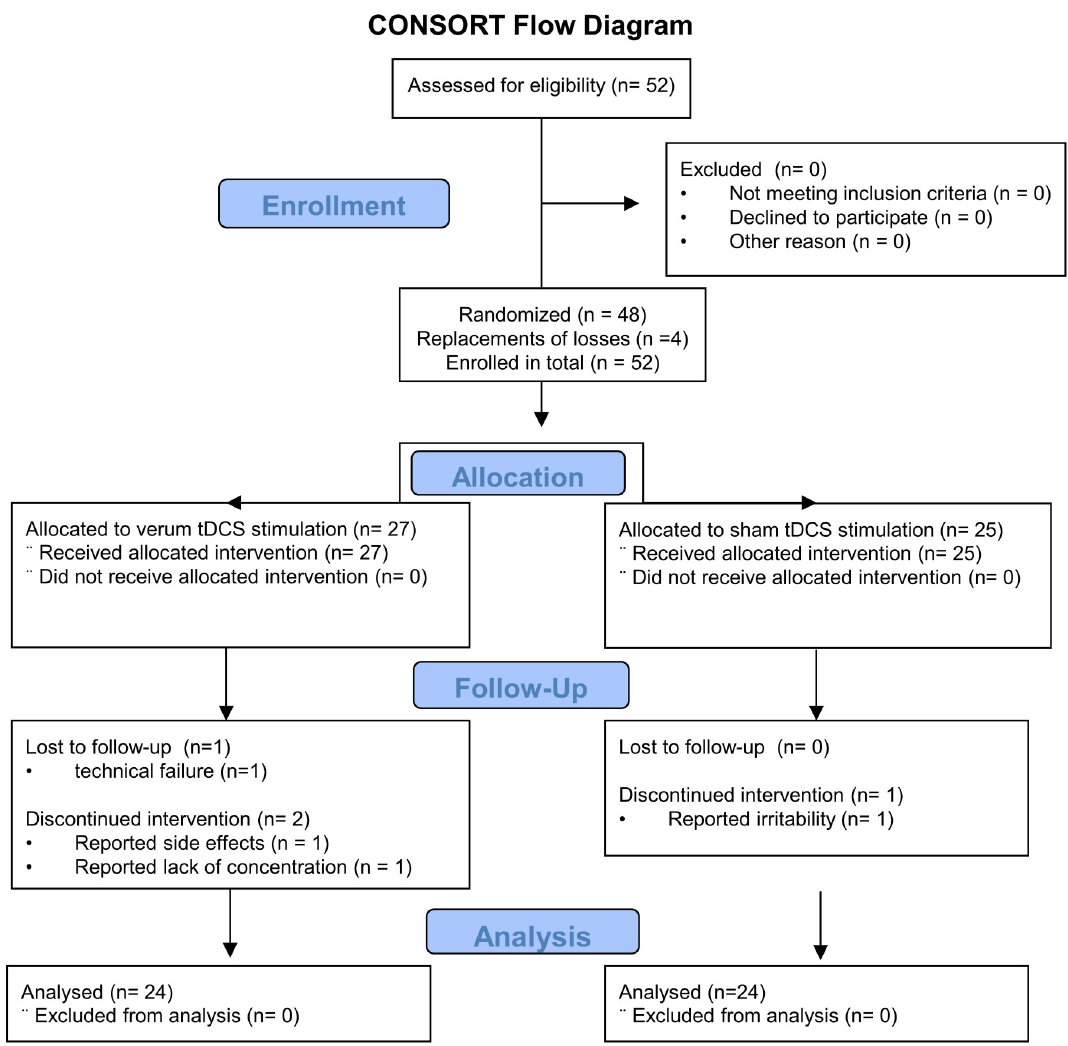
Fig 1. CONSORT flow diagram of the study. CONSORT Flow Diagram of the study giving an overview of the participants included in the study and finally analyzed.